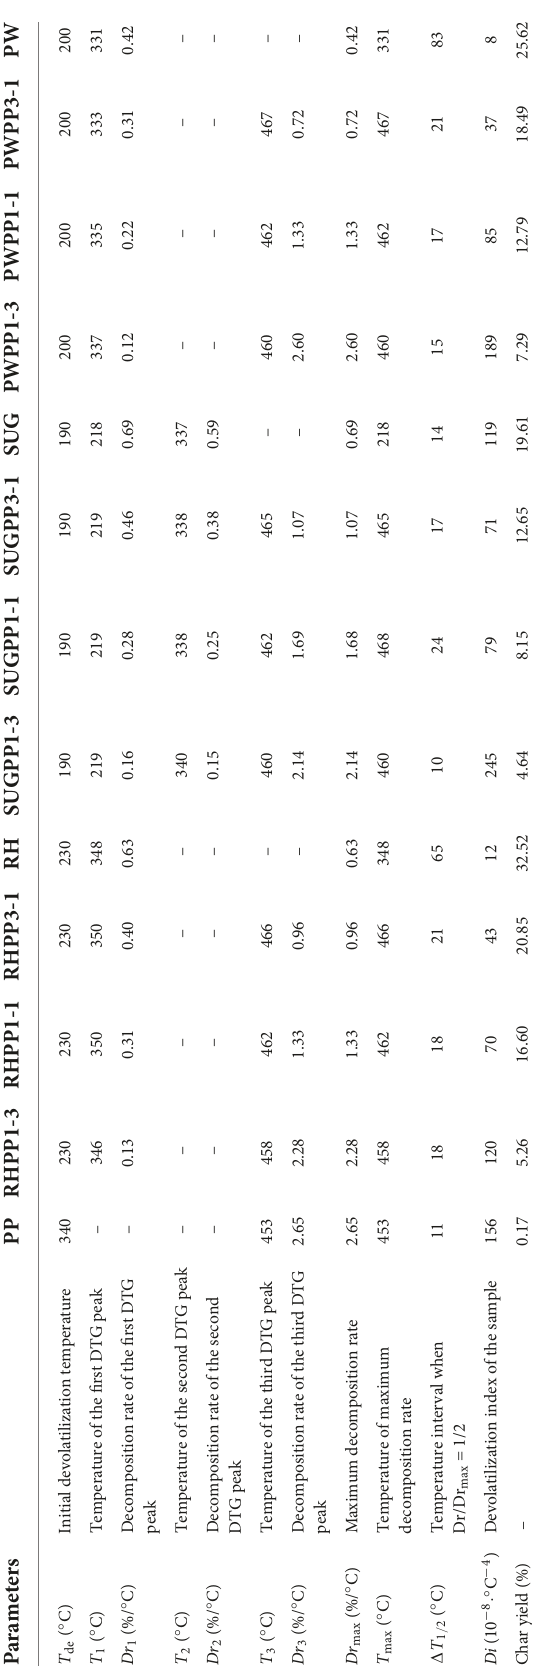
curve obtained from experimental values. The conversion value α = 0.5 is selected as a reference value, at which, master plot from all the reaction mechanism and experimental curve will intersect to each other at the value of [ Z ( α )/Z (0.5) ] = 1. The principal reaction mechanism for experimental value is decided by comparing the theoretical and experimental curves. The theoretical curve which is closest to the experimental curve is selected as reaction mechanism (Mishra et al., 2015; Dhyani et al., 2017; Li, 2022a,b).